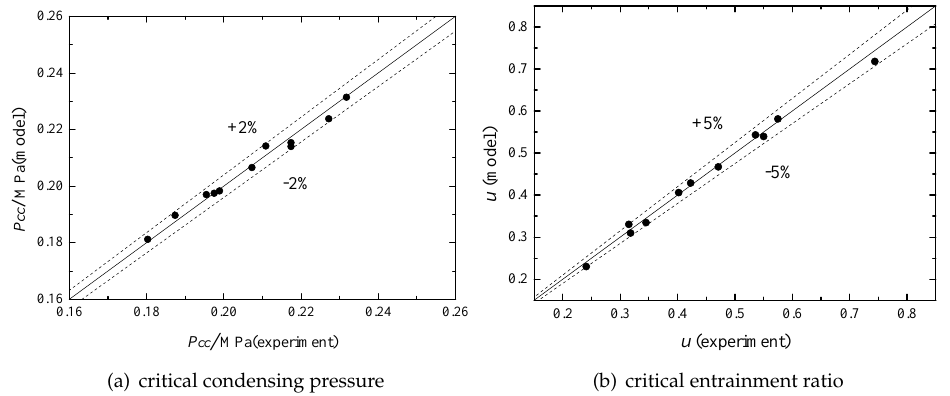
Figure 9. Comparisons of theoretical values of critical condensing pressure and critical entrainment ratios with experimental data using R245fa as a working fluid.